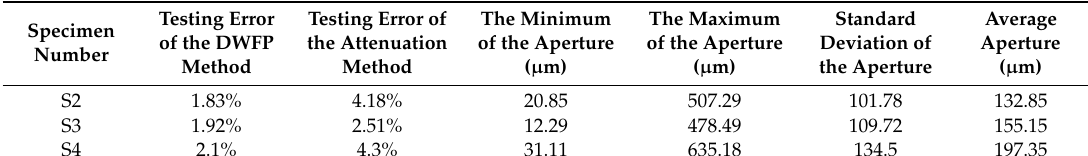
Table 1. The statistical results of parameters.